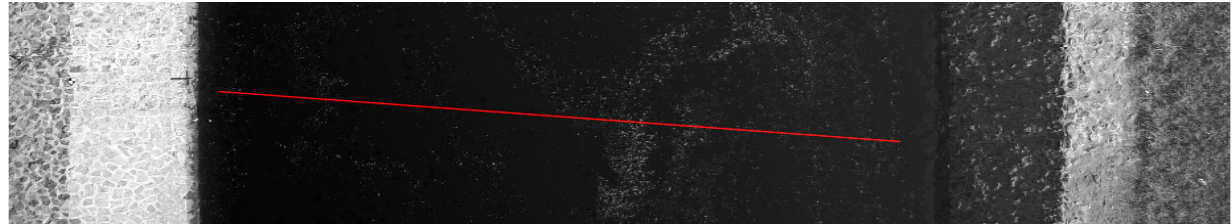
Figure 3. A part of the frame from Kolubara River video; the surface velocities are obtained along the displayed red line.